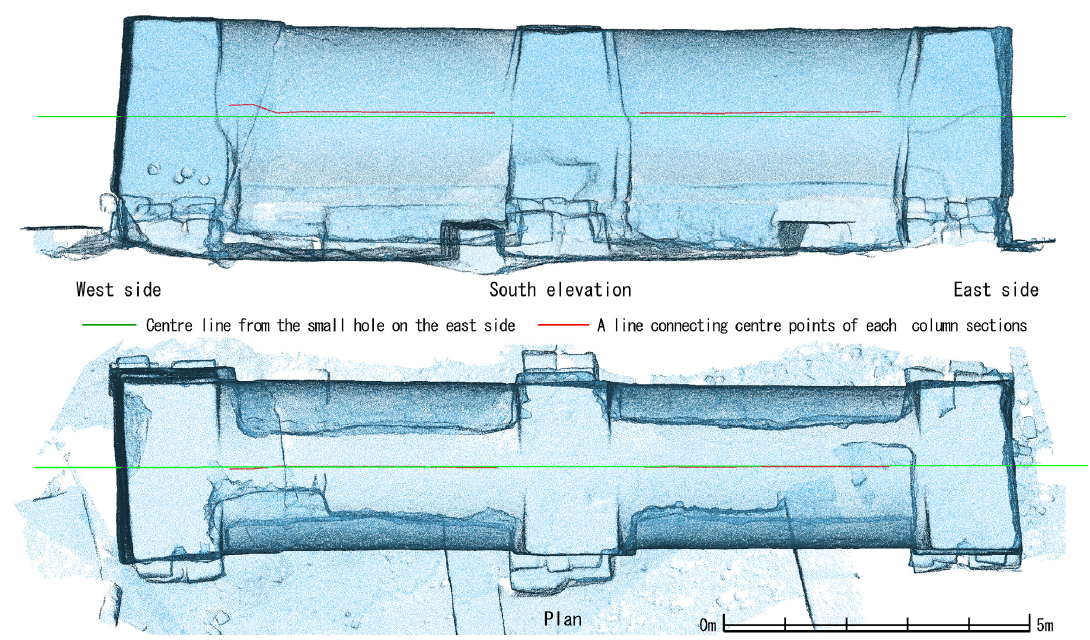
Figure 4. Comparison the centre line of the column with the line connecting centre points of each column